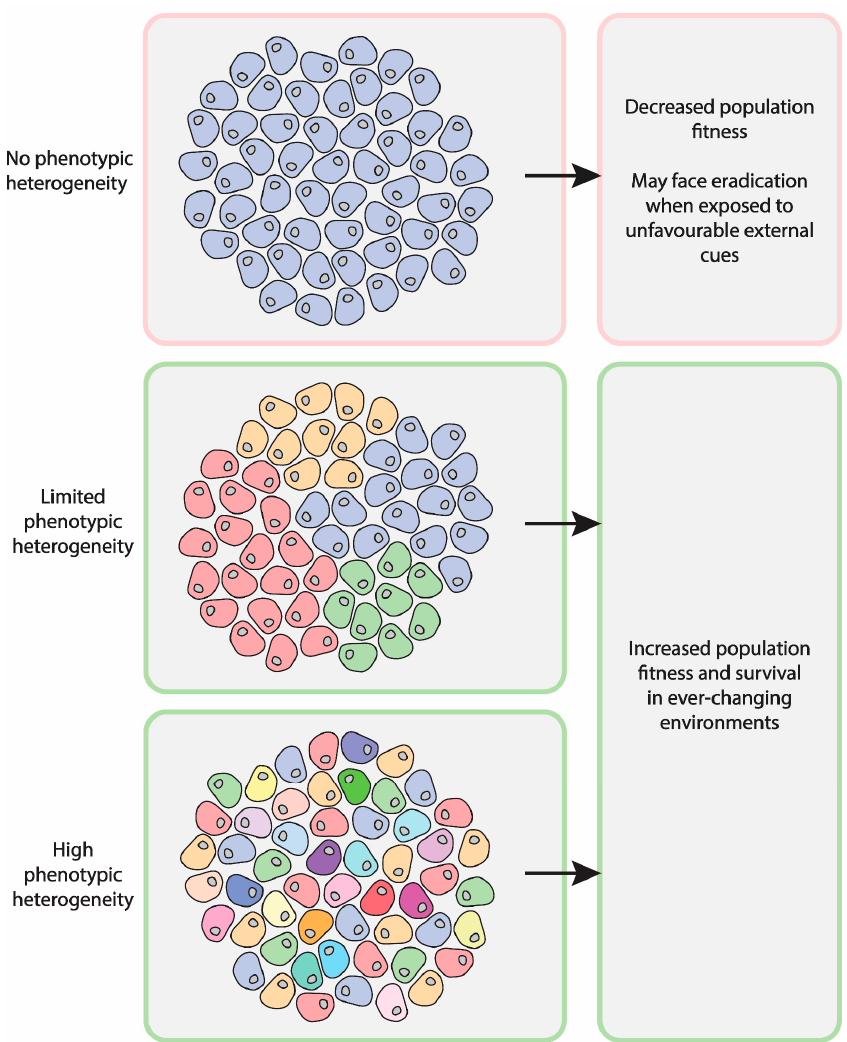
Figure 1. Phenotypic heterogeneity in populations of genetically identical cells. Isogenic populations of cells may display different levels of non-genetic heterogeneity. These differences may result in distinct levels of population fitness and survival capacity when exposed to harsh environmental conditions.